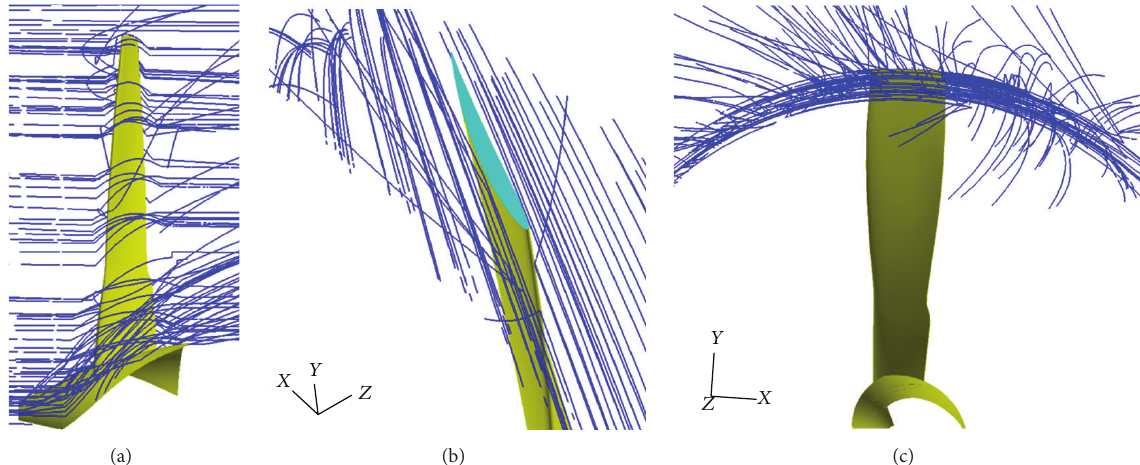
Figure 8: Sample of sand particle (250 𝜇 m) trajectories: (a) streamwise from hub to shroud, (b) near the tip, and (c) downstream of rotor blade reflecting particles crossing over the blade tip.